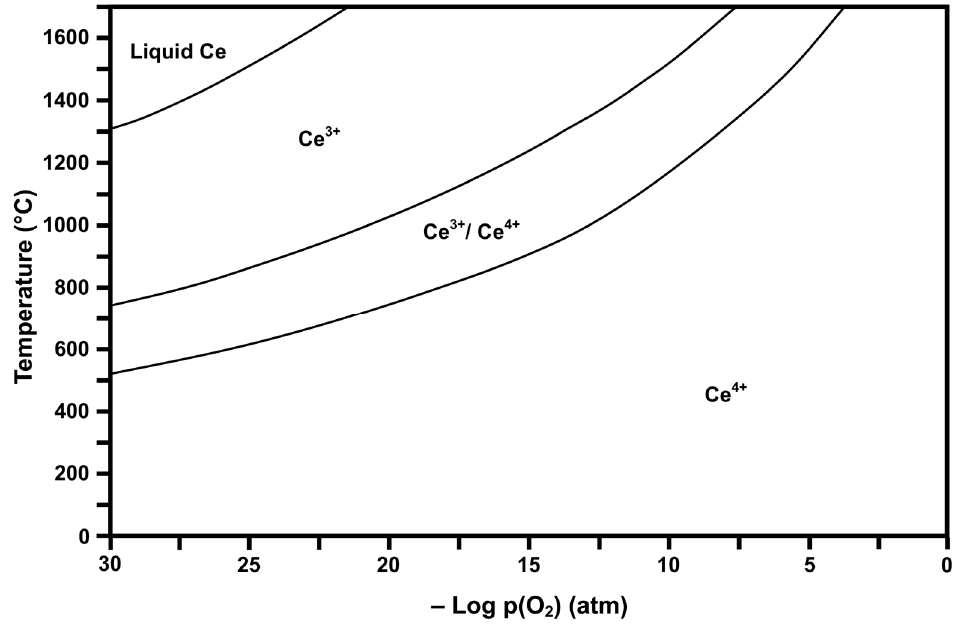
Figure 2. Calculated Ce stability diagram (Ce 4+ = CeO 2 , Ce 3+ /Ce 4+ = Ce 3 O 5 or CeO 2 ∙ Ce 2 O 3 , Ce 3+ = Ce 2 O 3 ).